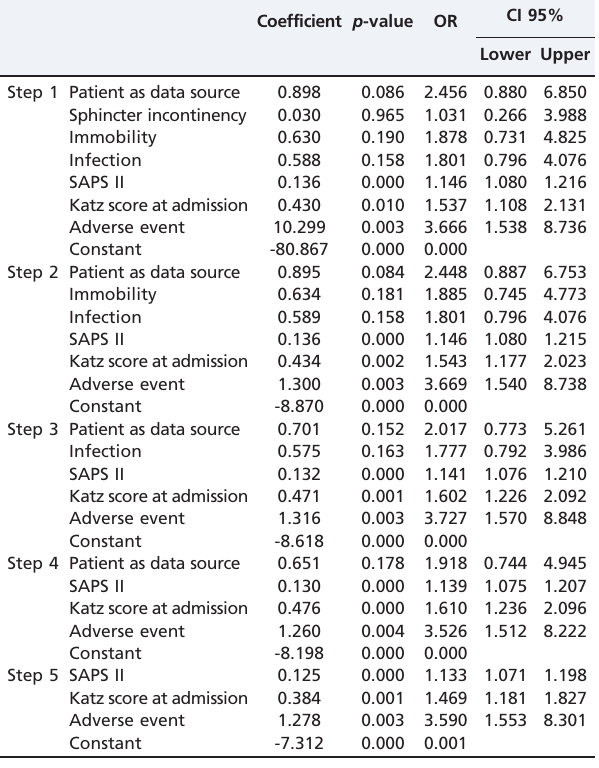
Step 1 Patient as data